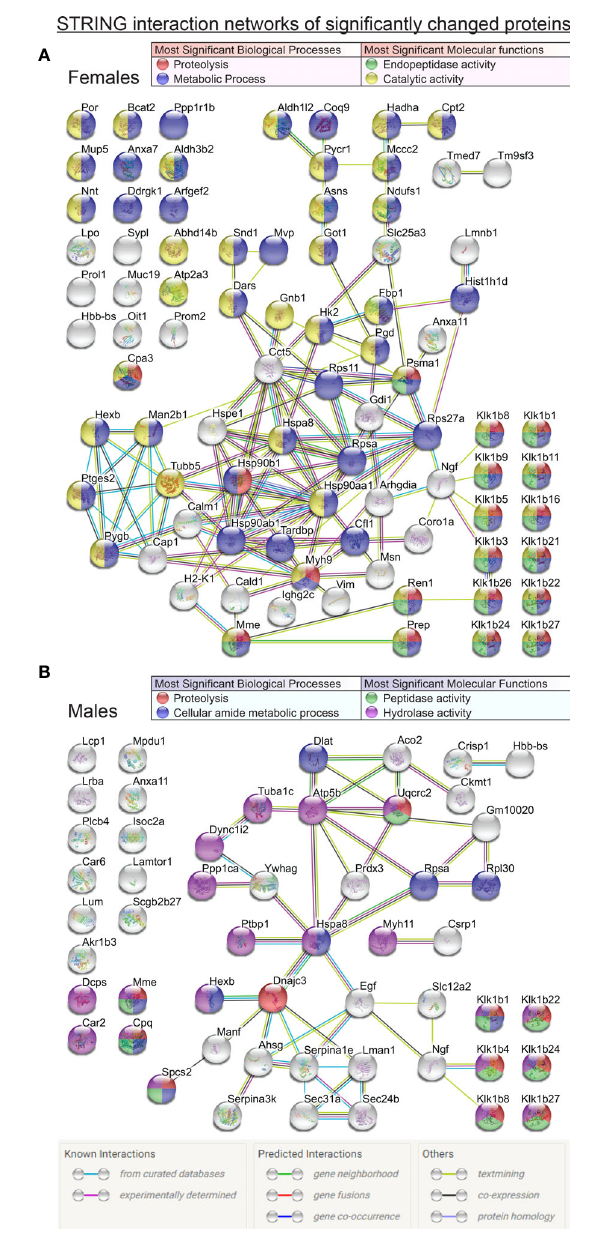
FIGURE 3 | Comprehensive STRING interaction networks for the proteins that were found in signi fi cantly different relative abundances (t-test p<0.05) in the mass spectrometry proteomic data comparisons between FWT vs FKO animals (A) and MWT vs MKO animals (B) . Protein nodes are color coded according to their classi fi cation based on the most signi fi cant biological processes and molecular functions of the network proteins (legend tables). Edge color code in image